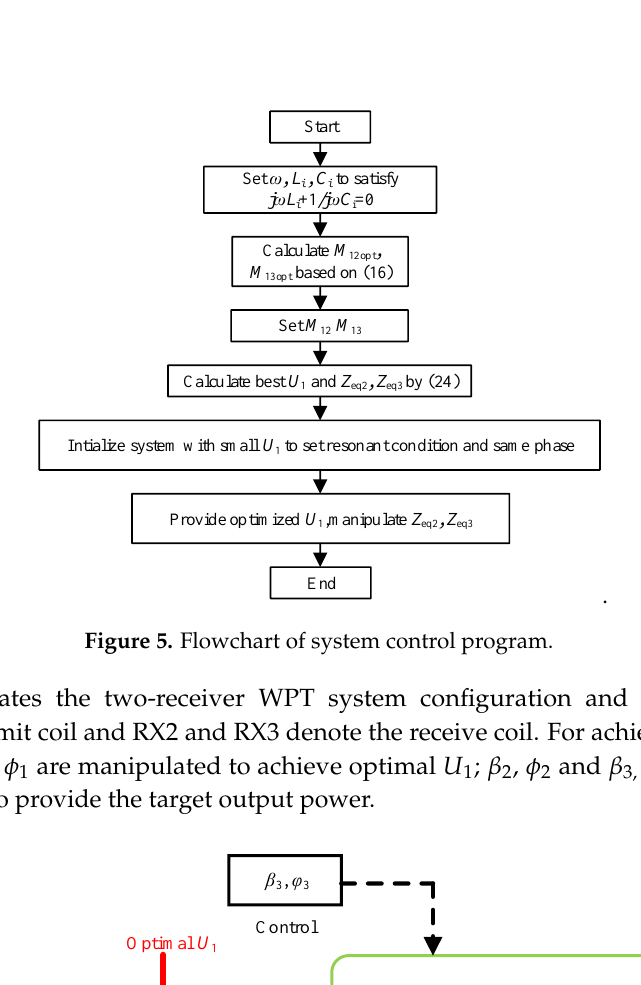
Table 1. Key parameters of proposed system.